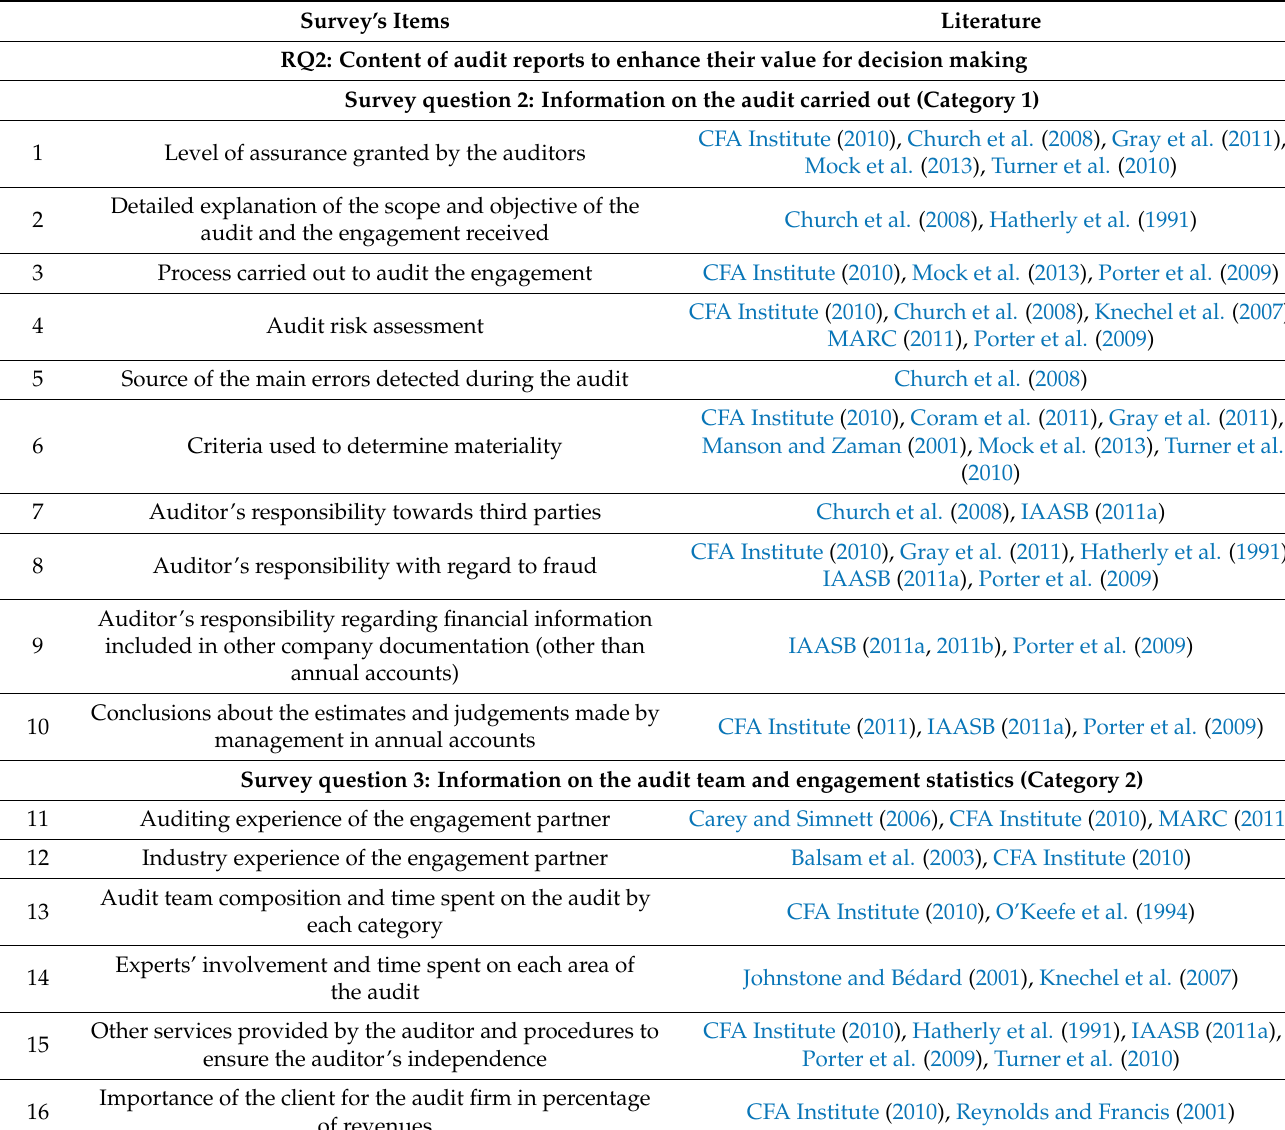
Table 2. Survey’s items and